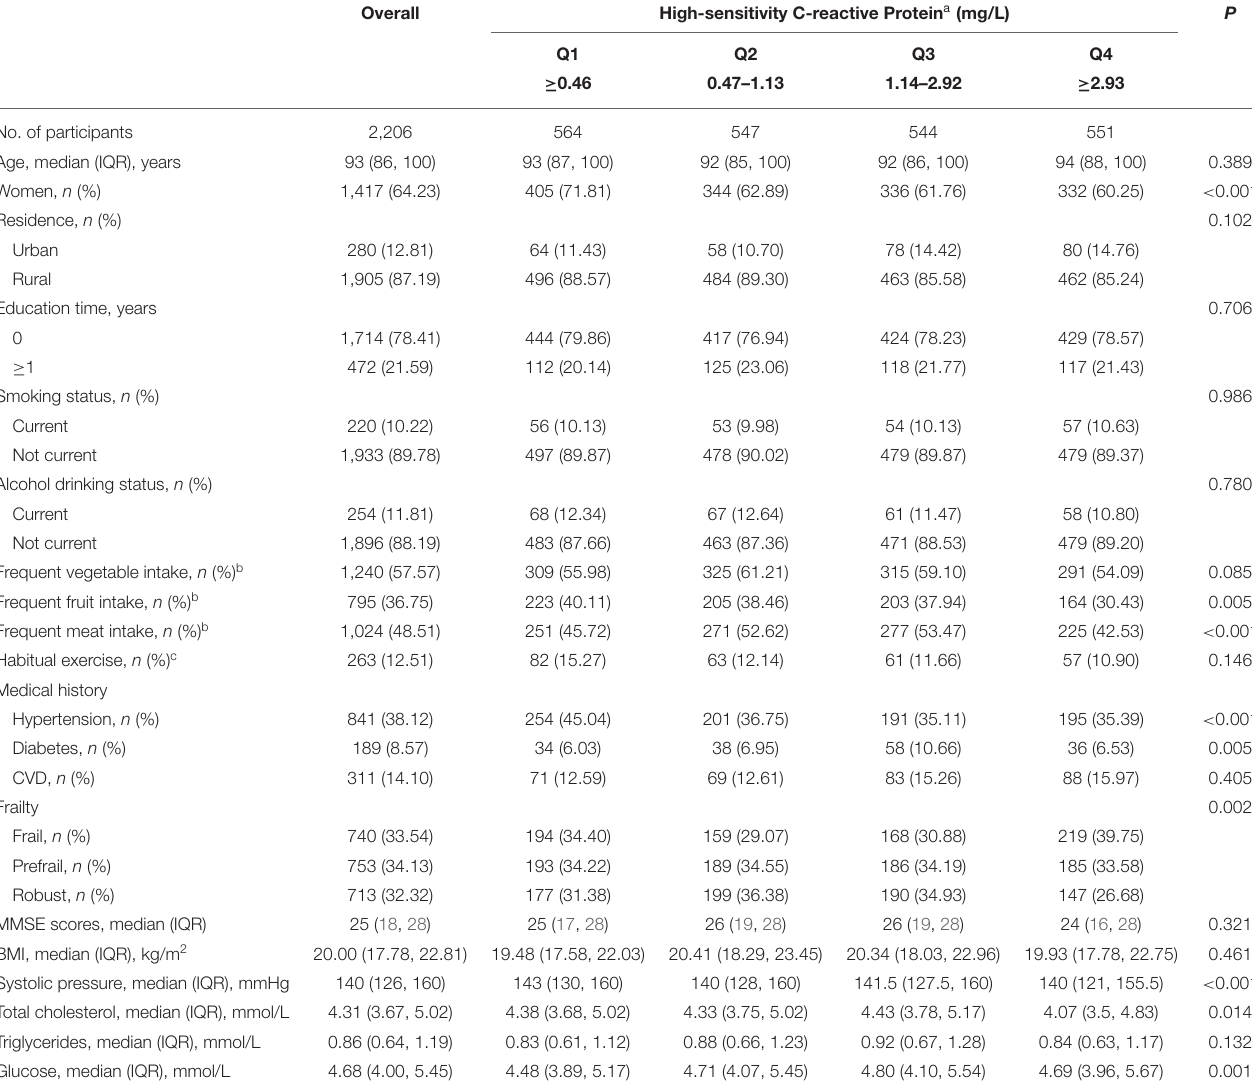
TABLE 1 | Characteristics of participants by quartiles of high-sensitivity C-reactive Protein. Overall High-sensitivity C-reactive Protein a